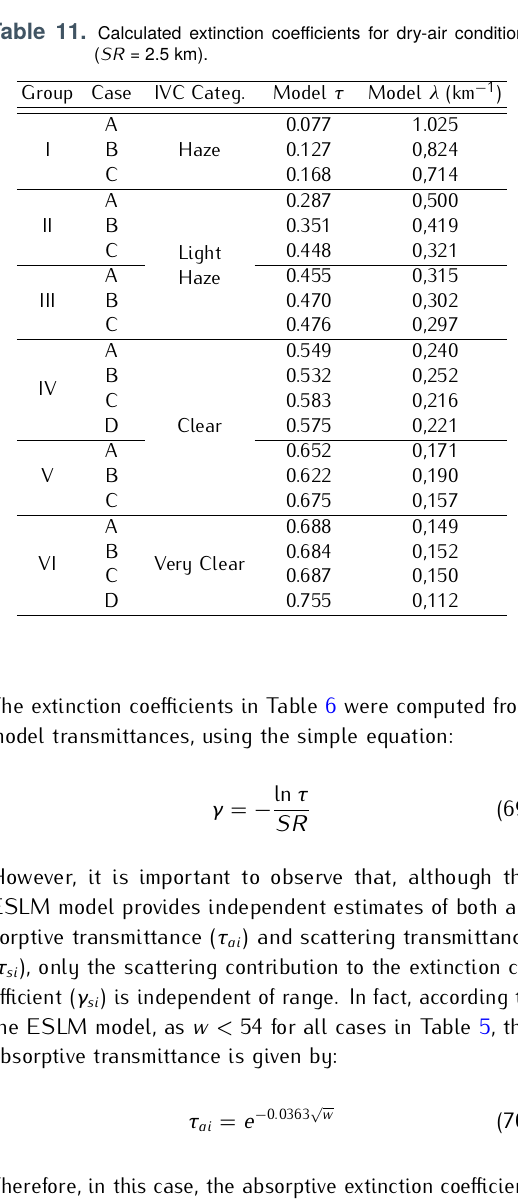
Table 11. Calculated extinction coefficients for dry-air conditions ( SR = 2.5 km). Group Case IVC Categ.